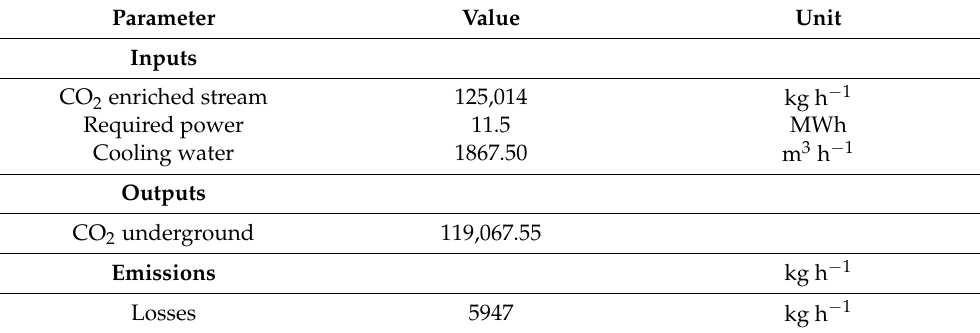
Table 6. Inventory of the underground storage